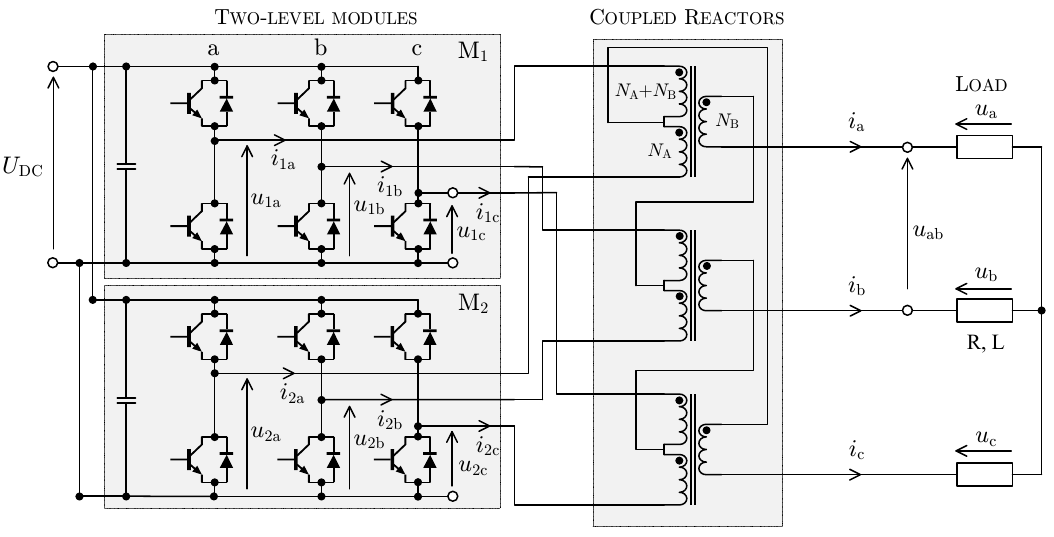
Figure 1. Twelve-pulse modular voltage source inverters (VSI) with coupled reactors.